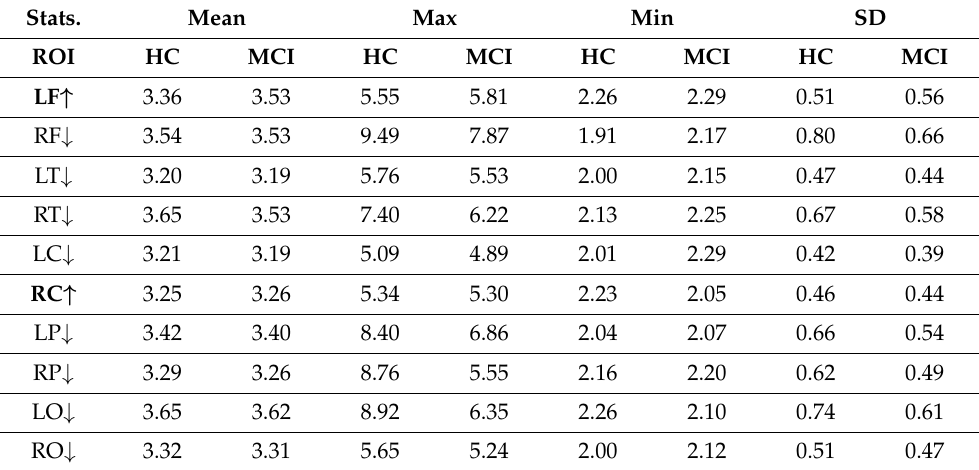
Table 1. Statistical measures of FCs based on MS-COH for ten ROIs. Each ROI contains 3600 summed MS-COHs from the nine remaining ROIs. The highlighted (in bold) values relate to the hyper-connectivity of the regions for MCI